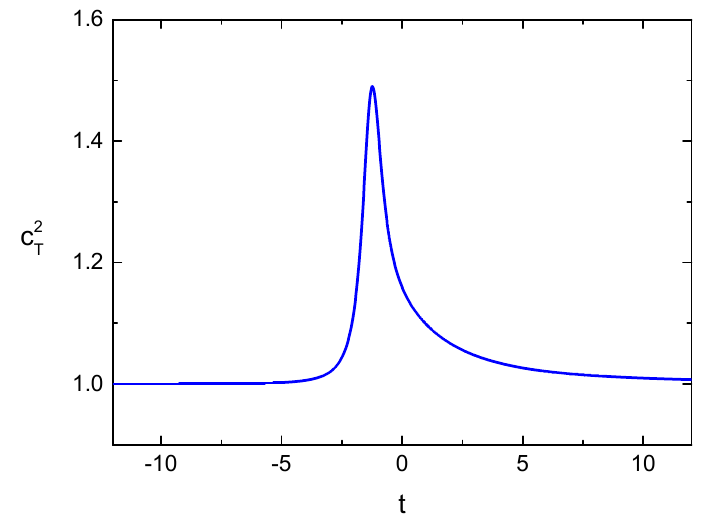
Figure 3 . Dynamics of c 2 with respect to cosmic time t . The model parameters are set by T